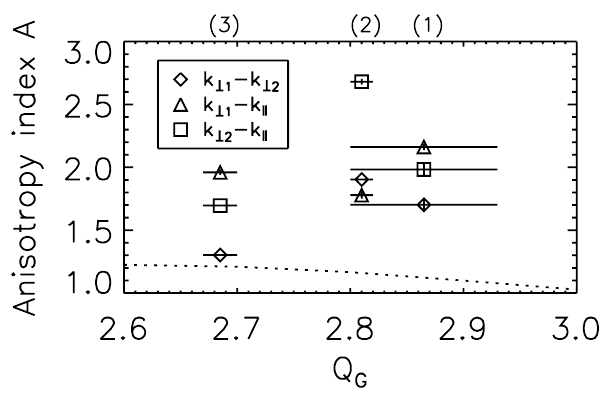
Fig. 4. Values of the anisotropy index as a function of the tetrahe- dral configuration parameter Q G . The numbers (1)–(3) at the top of the panel denote the analyzed time interval. Three symbols denote the three projected planes in Fig. 3 for each time interval. Error bars reflect the variation of tetrahedral shape during the measure- ment. Dotted curve represent the artificial anisotropy produced by irregular